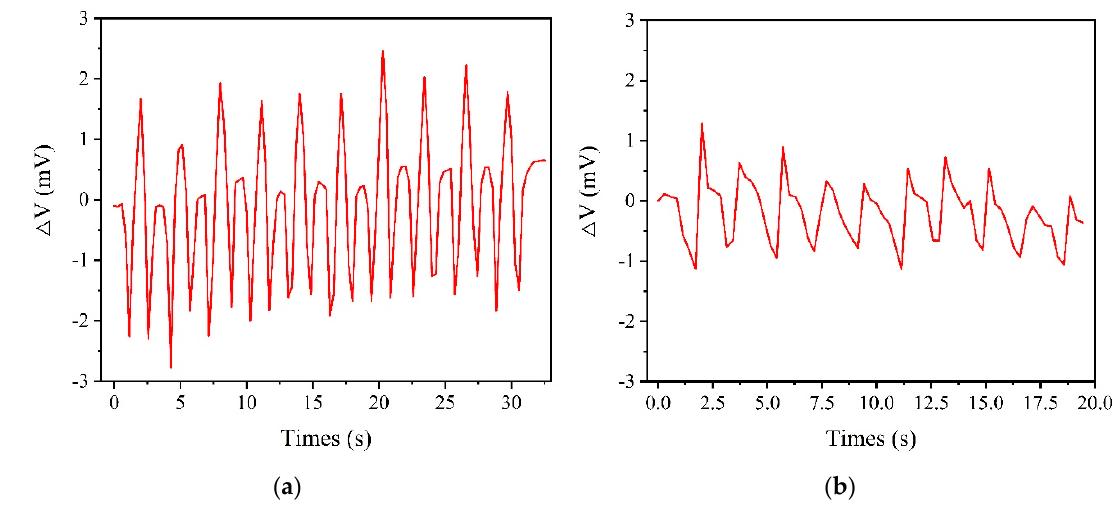
Figure 16. ( a ) The change in output voltage of the accelerometer during 10 deep-squatting cycles. ( b ) The change in output voltage of the accelerometer while walking 20 steps in place.